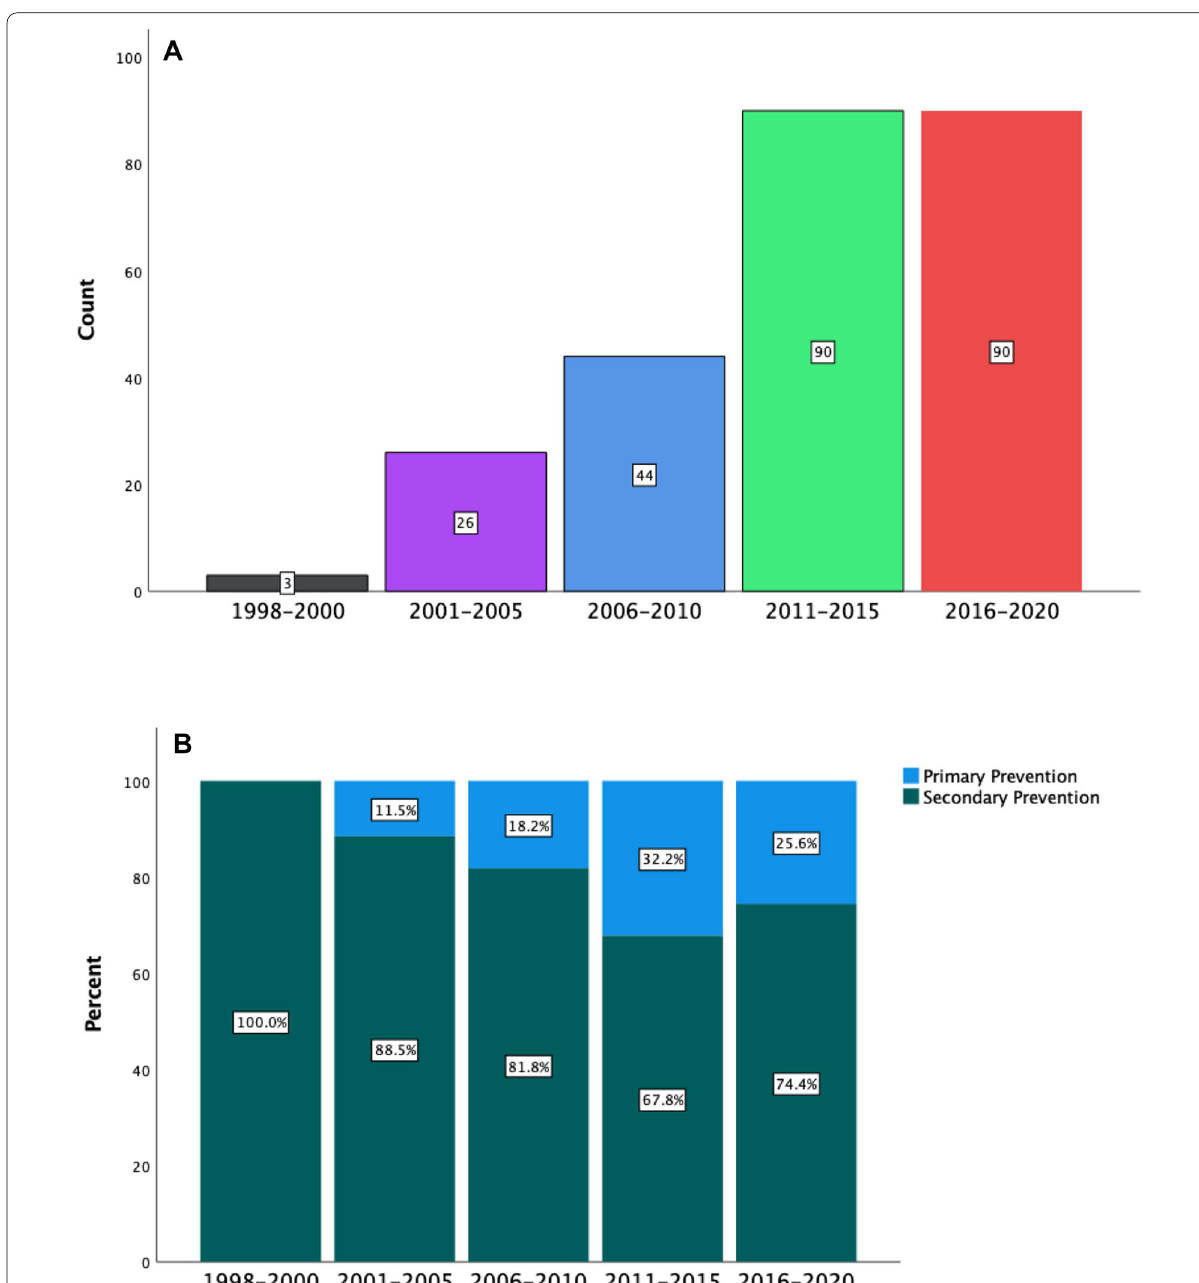
Fig. 1 A Bar graph depicting the overall ICD implantation trends from 1998 to 2020. B Bar graph depicting increasing proportions of